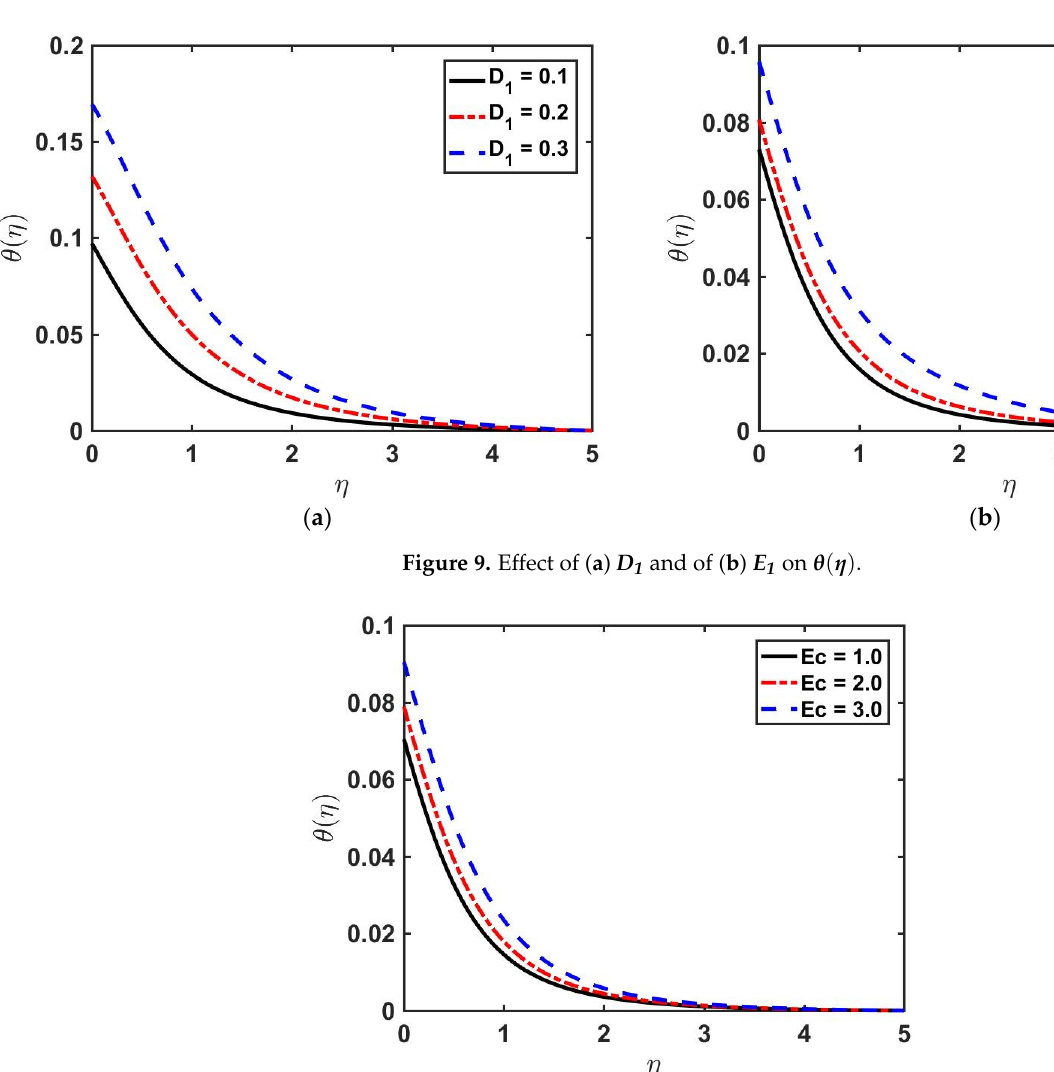
Figure 8. Effect of 𝑹𝒅 on 𝜽(𝜼) .